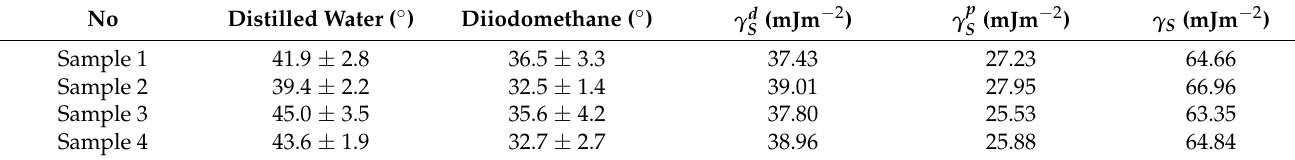
Table 3. Contact angles and surface energies of samples (monocrystalline silicon